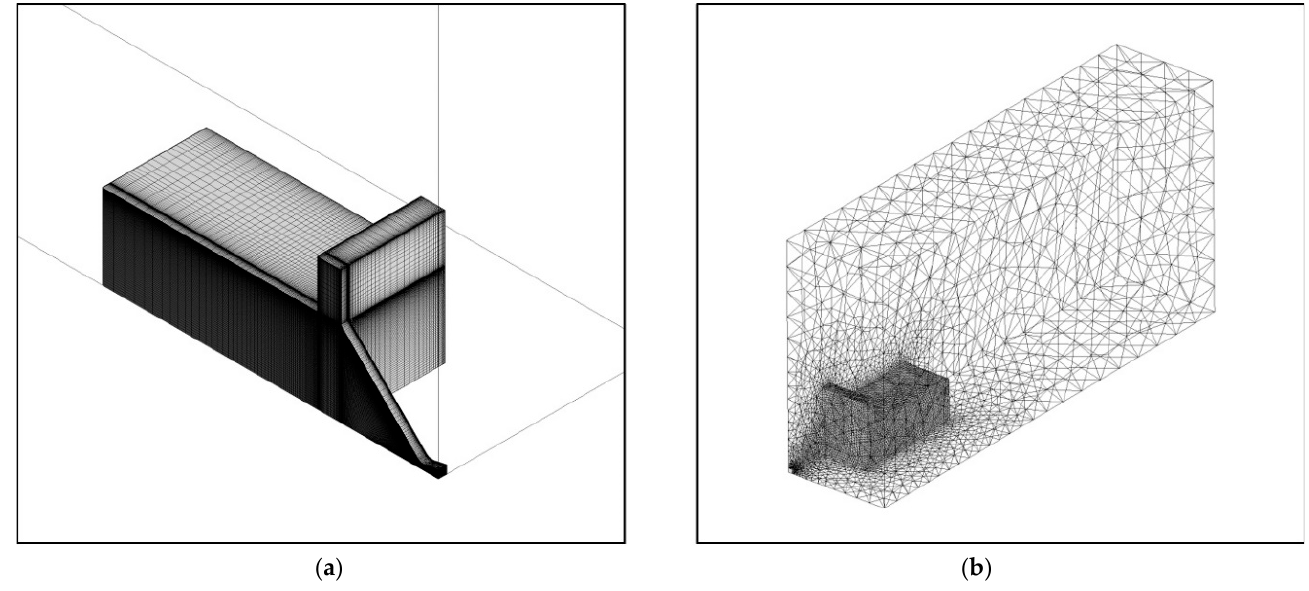
Figure 2. Microthruster computational domain for conjugate heat transfer analysis. ( a ) Left side view. ( b ) Right side view.